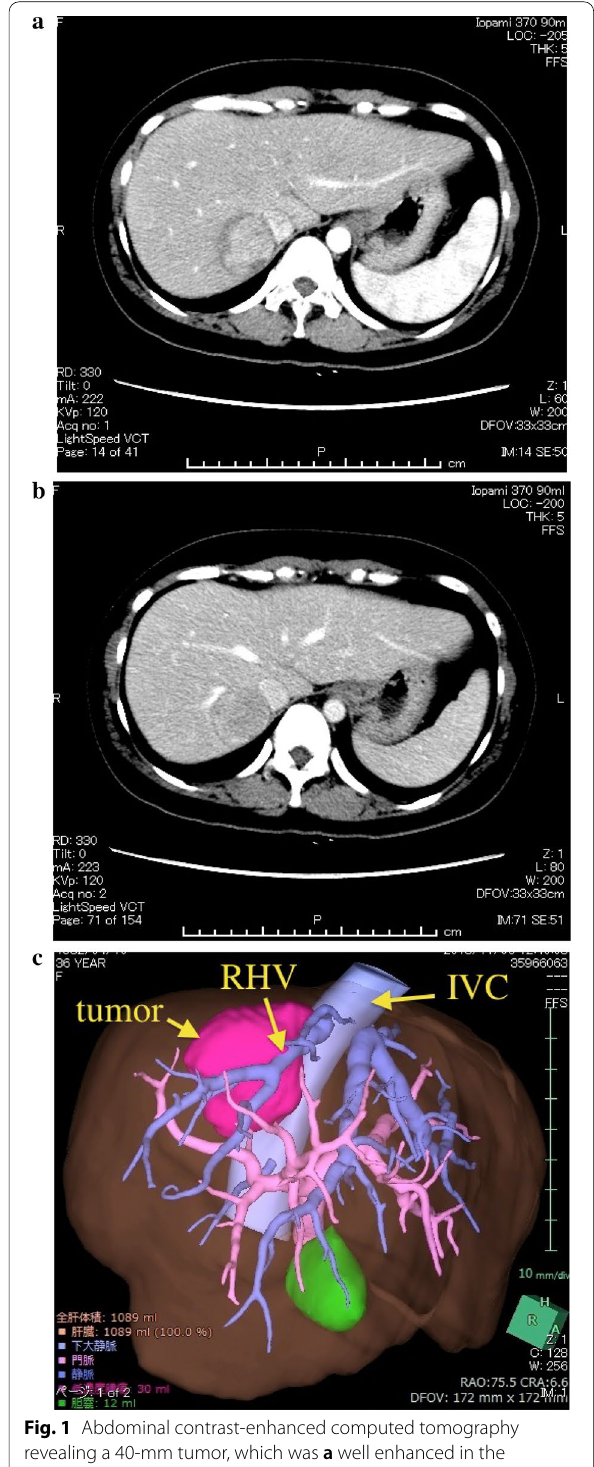
Fig. 1 Abdominal contrast-enhanced computed tomography revealing a 40-mm tumor, which was a well enhanced in the arterial phase and b washed out in the portal venous and delayed phases, suggesting hepatocellular carcinoma recurrence. The three-dimensional image (VINCENT) showed the tumor adjacent to the inferior vena cava and right hepatic vein ( c